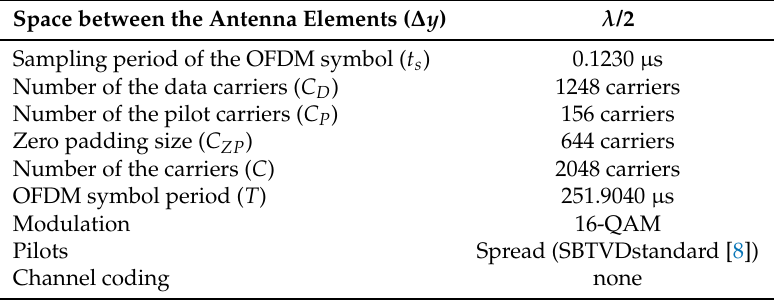
Table 2. Constant parameters used in all simulations.